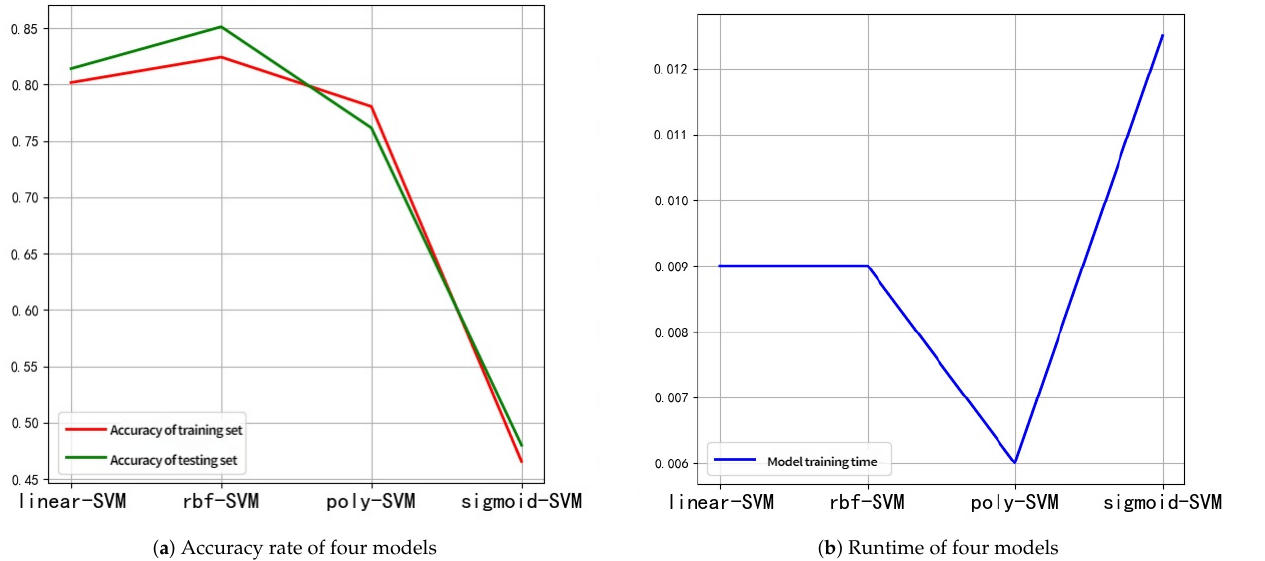
Figure 6. Comparison of different kernel function models for SVM in optical interconnect